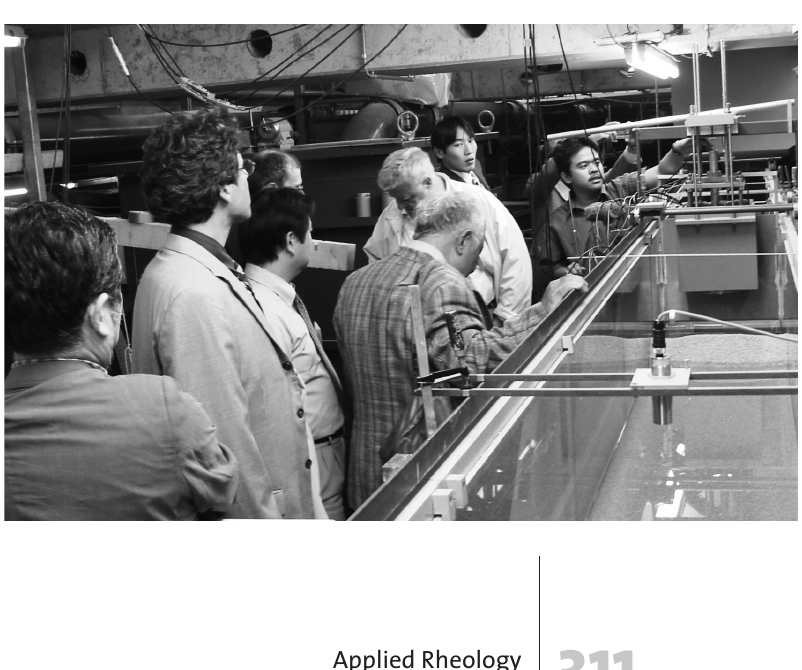
Figure 4 (below): Visit of the experimental hydraulic laboratory of the